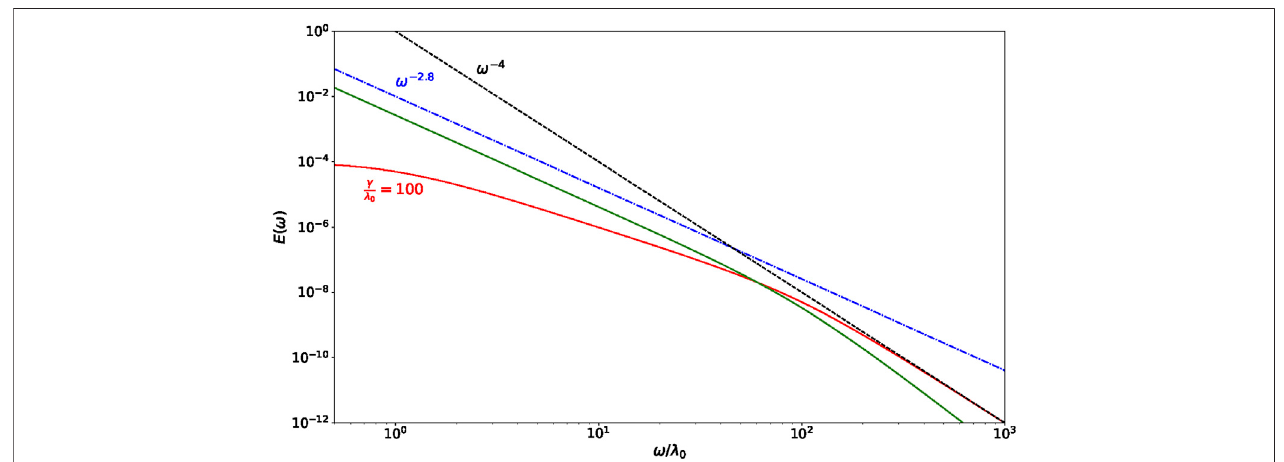
FIGURE1| E ( ω ) vs. ω / λ 0 asobtainedfrom Eq.(5) for c / λ 0 (cid:2) 100(redsolidline)andfrom Eq.(7) for μ (cid:2) 1 . 8and c (cid:2) 100(greensolidline). E ( ω ) ∼ ω − 2 . 8 (bluedash- dotted line) and E ( ω ) ∼ ω − 4 (black dashed line) are shown as